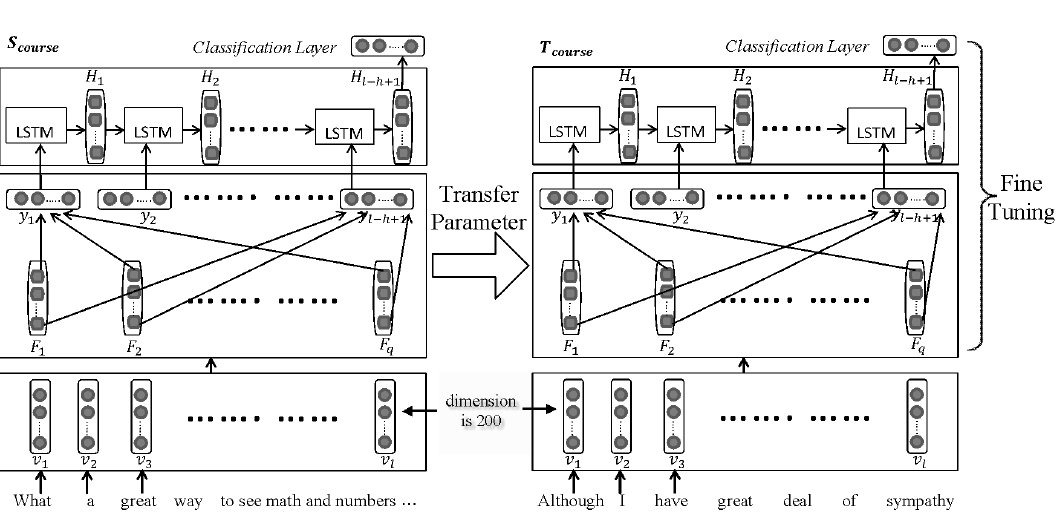
Figure 1. Architecture of convolutional-LSTM (ConvL) for cross-domain MOOC forum post text